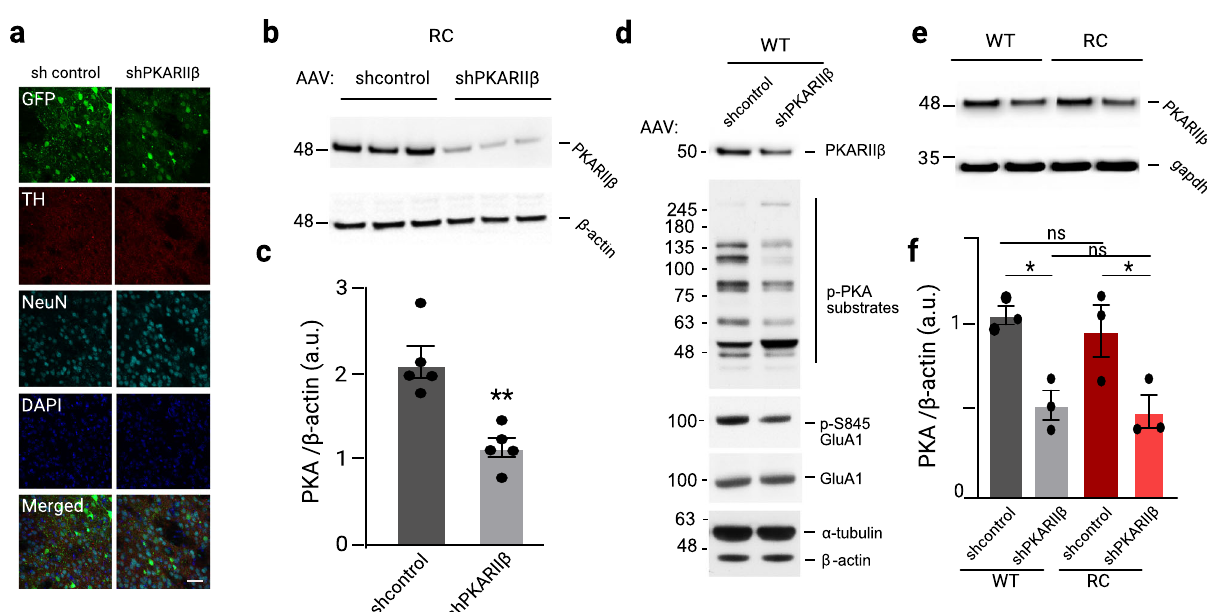
Fig. 5 PKARII β knockdown modi fi es p-PKA signaling in the striatum of WT and RC mice. a Striatal sections of AAV-eGFP-shcontrol and AAV-eGFP- shPKARII β injected WT and RC mice. Scale bar, 50 μ m. b Western blot analysis of striatum of WT mice injected with AAV-sh-control and AAV-sh- PKARII β viral constructs probed for PKARII β . c Quanti fi cation of PKARII β from b normalized to β -actin. Summary graphs represent the mean, while error bars SEM, ** p < 0.01, unpaired t-test ( n = 5). d Western Blot analysis of striatum of WT mice injected with, AAV-sh-control and AAV-sh-PKARII β probed for PKARII β , pPKARII β , p-S845GluA1, GluA1 and β -actin. e Western blot analysis of striatal extracts from WT and RC mice injected with AAV-sh-control and AAV-sh-PKARII β viral constructs probed for PKARII β , and gapdh. f Quanti fi cation of PKA bands normalized to gapdh. Summary graphs represent the mean, while error bars SEM, * p < 0.05, ** p < 0.01, Tukey post hoc following one-way ANOVA ( n =